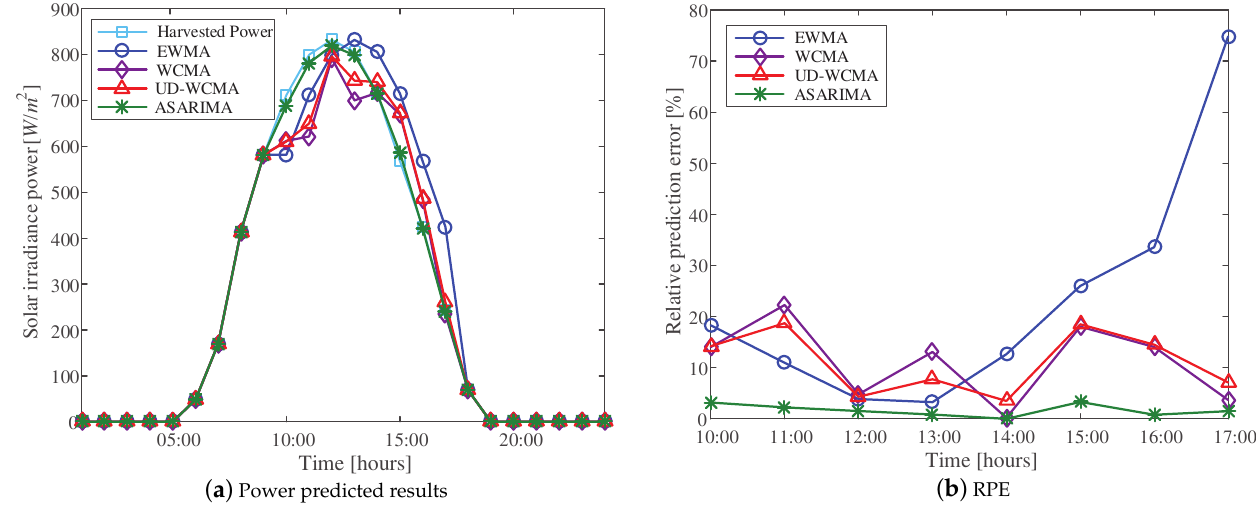
Figure 8. Power predicted and prediction error for 17 April